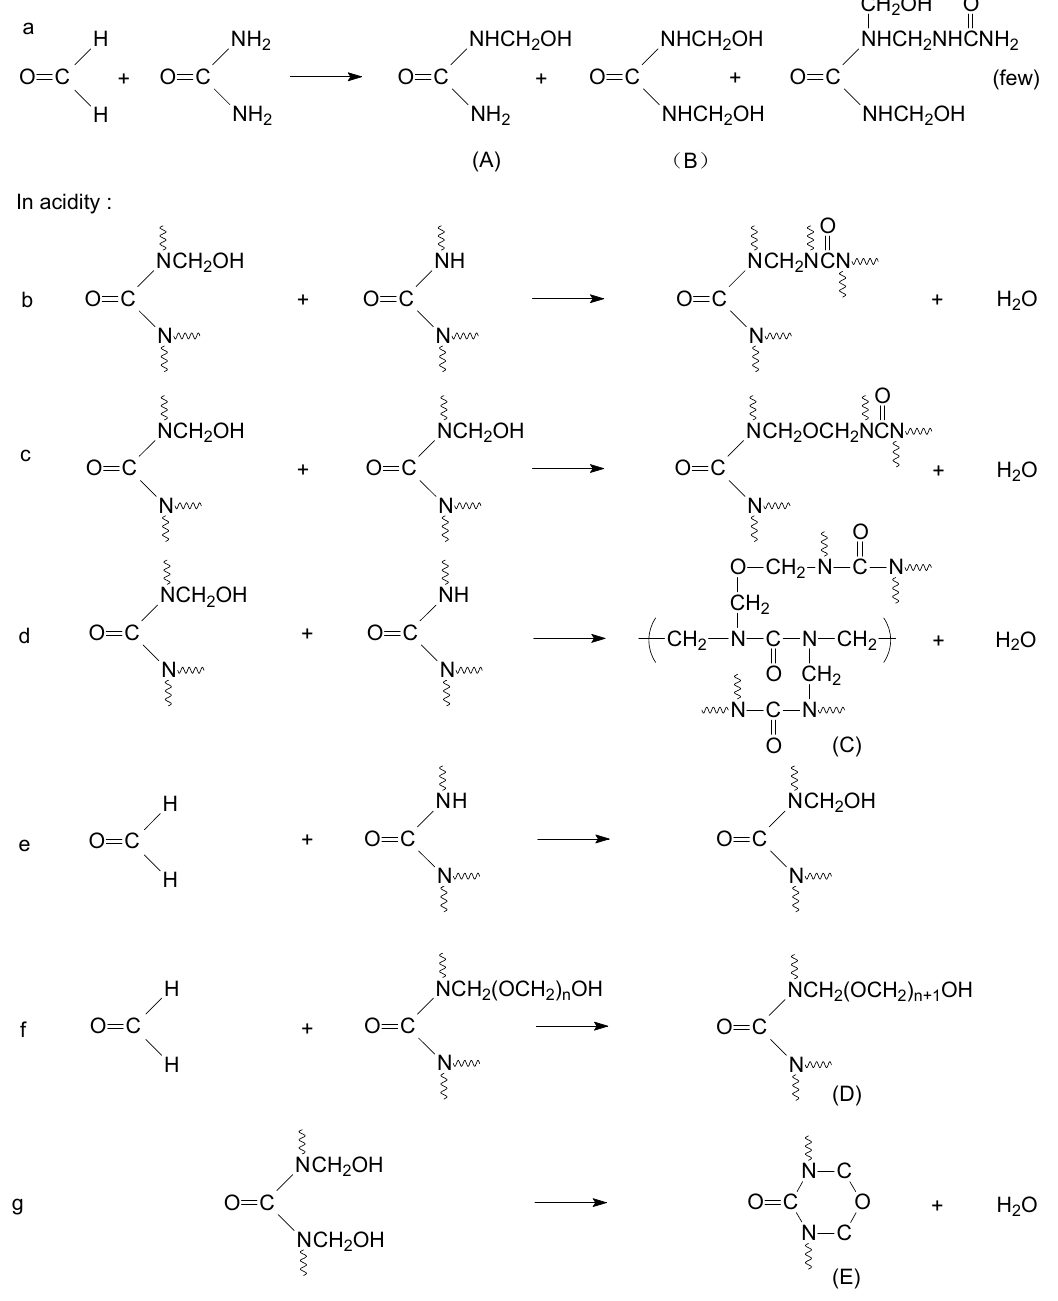
Scheme 1. Main reactions during the preparation of the microcapsules.